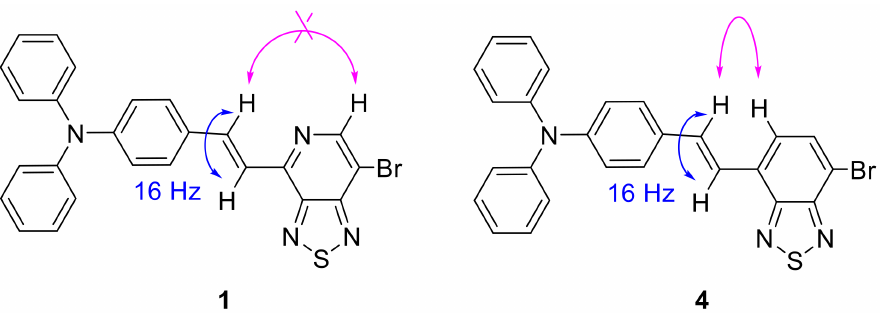
Figure 1. Cross-peak interactions in NOESY NMR spectra of compounds 1 and 4